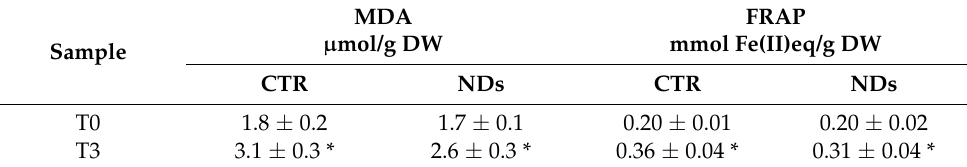
Table 1. MDA level and FRAP value in C. reinhardtii cultures pre-incubated with 40 µ g hNDs/mL for 24 h and in control cells exposed to 3 µ M MV. Means of 2 independent experiments with 3 biological replicates ( ± SD, n =